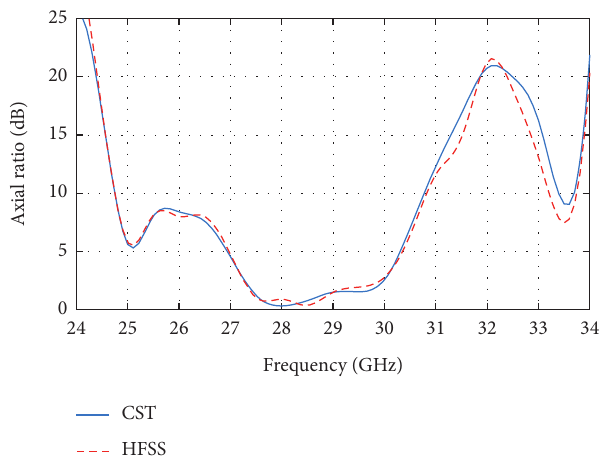
Figure 16: Simulated axial ratio of the 16 × 16 CP array antenna.